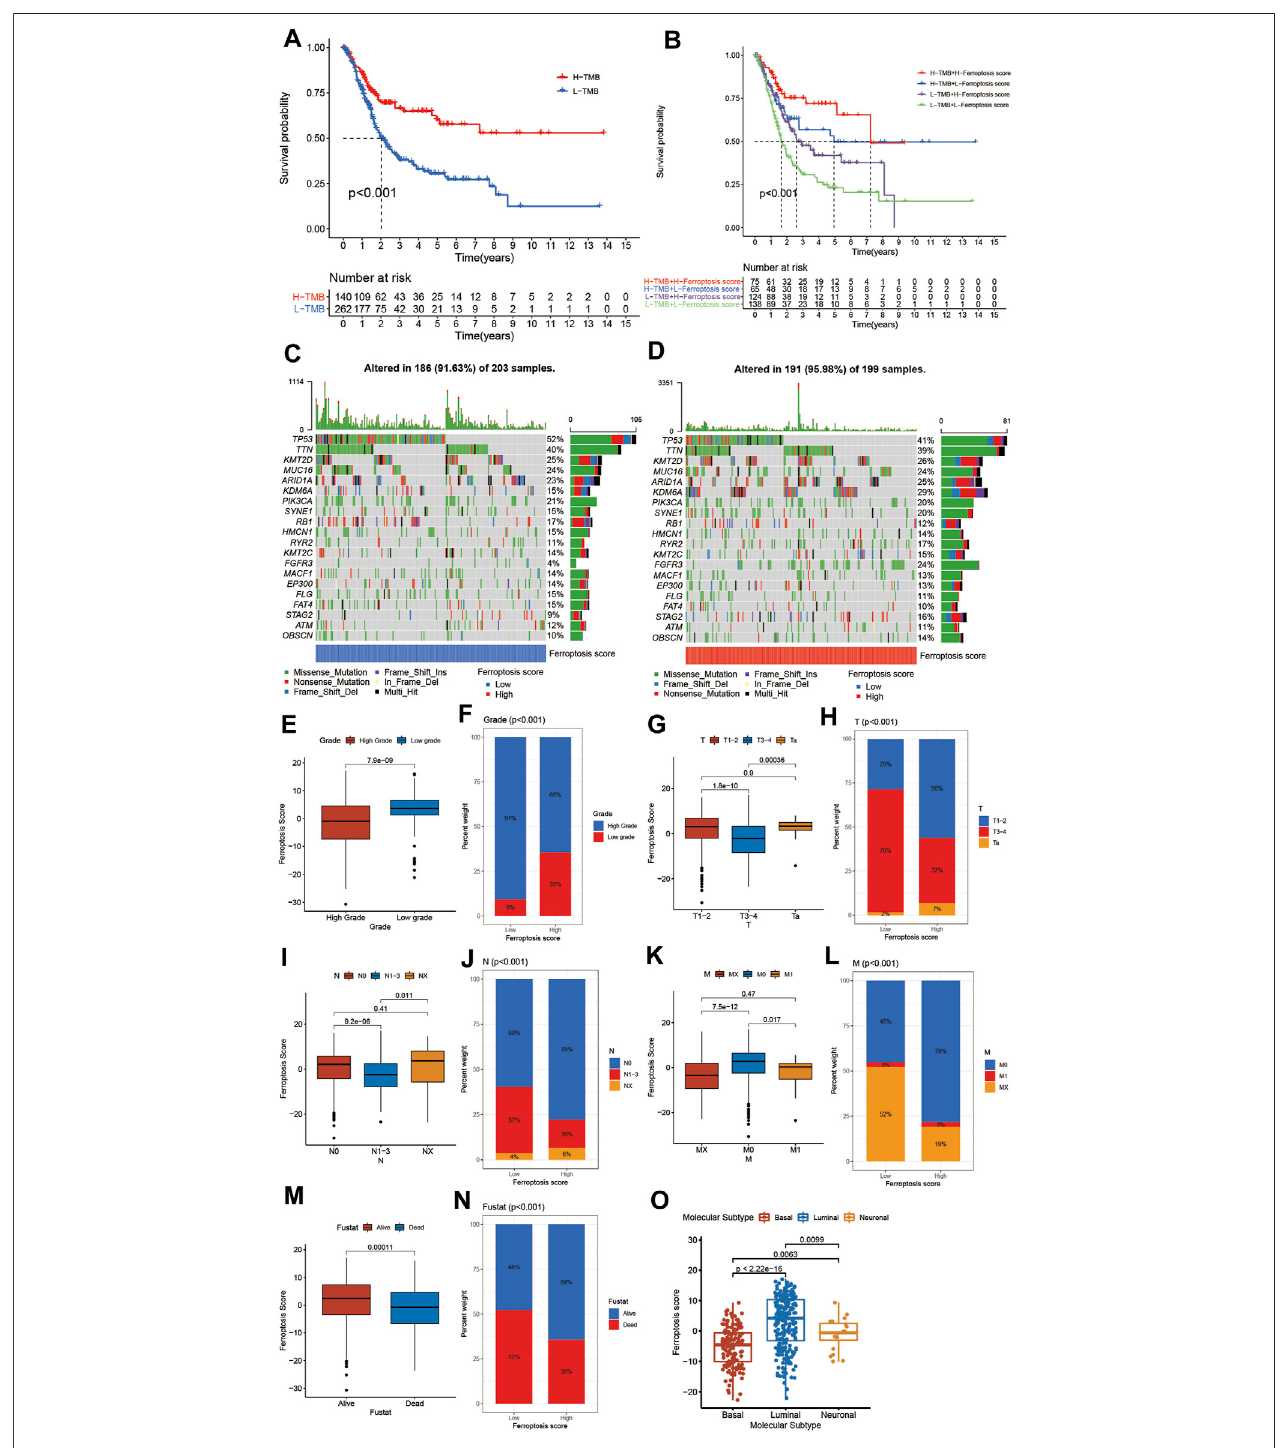
FIGURE 6 | Characteristics of ferroptosis in tumor somatic mutation and tumor stage. (A) Survival analyses for low (262 cases) and high (140 cases) TMB patient groupsintheTCGA-BLCAcohortusingKaplan – Meiercurves( p < 0.001,Log-ranktest). (B) SurvivalanalysesforfourgroupsgroupedaccordingtoTMBandferroptosis score in the TCGA-BLCA cohort using Kaplan – Meier curves including 75 cases in the high TMB and high ferroptosis score group, 65 cases in the high TMB and low ferroptosis score groups, 124 cases in the low TMB and high ferroptosis score group, and 138 cases in the low TMB and low ferroptosis score group. The high TMB and high ferroptosis score group showed signi fi cantly better overall survival than the other three groups ( p < 0.001, Log-rank test). (C,D) Waterfall plot of tumor somatic mutation established by those with low ferroptosis score (C) and high ferroptosis score (D) . Each column represented individual patients. The upper barplot